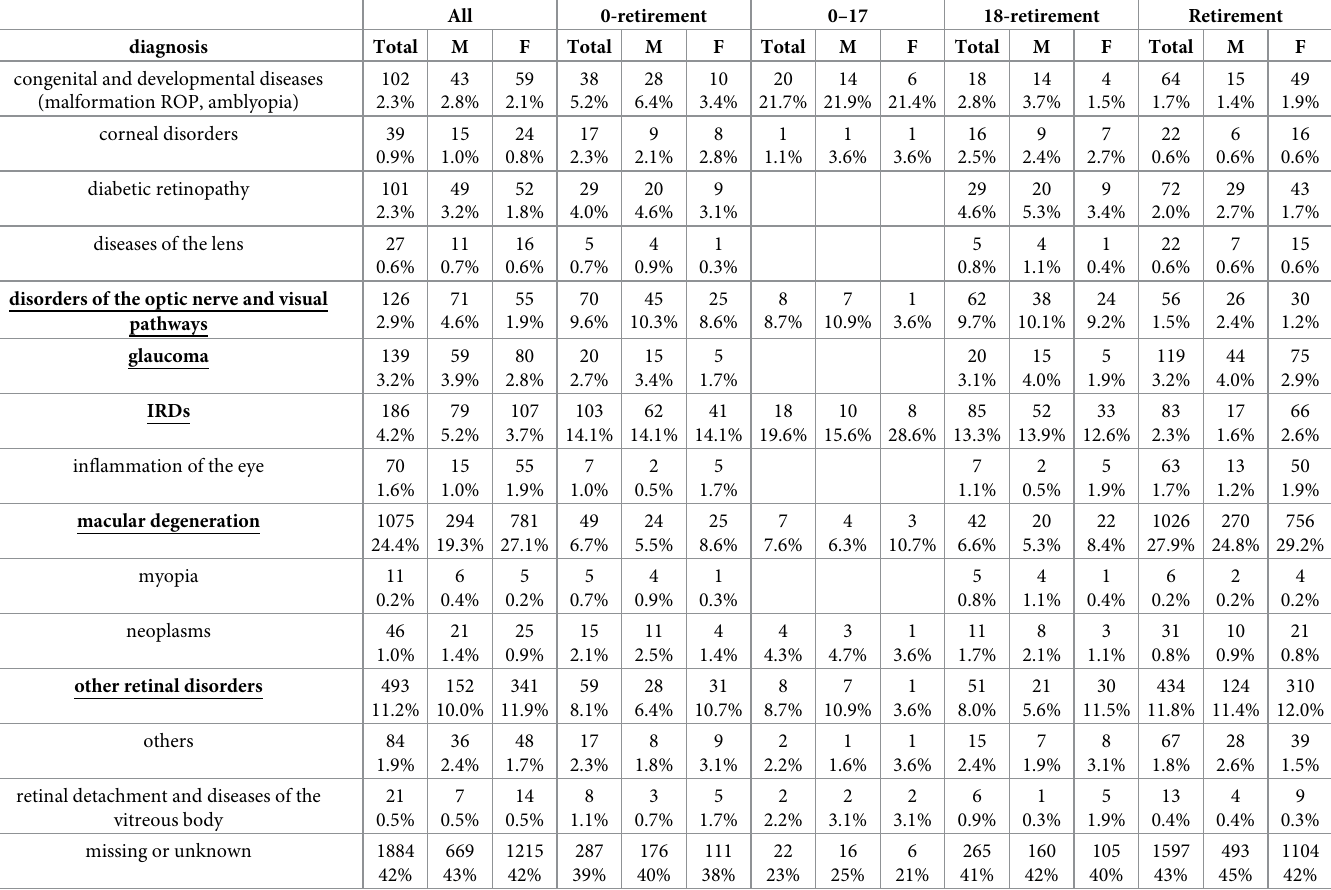
Table 3. Number and percentage of all patients who requested a health care allowance in 2017 and 2018 in Austria because of a diagnosis-related minimum classifi- cation of visual impairment, blindness or deaf-blindness according to the diagnosis, age and sex (M = male, F = female, most frequent diseases bold and